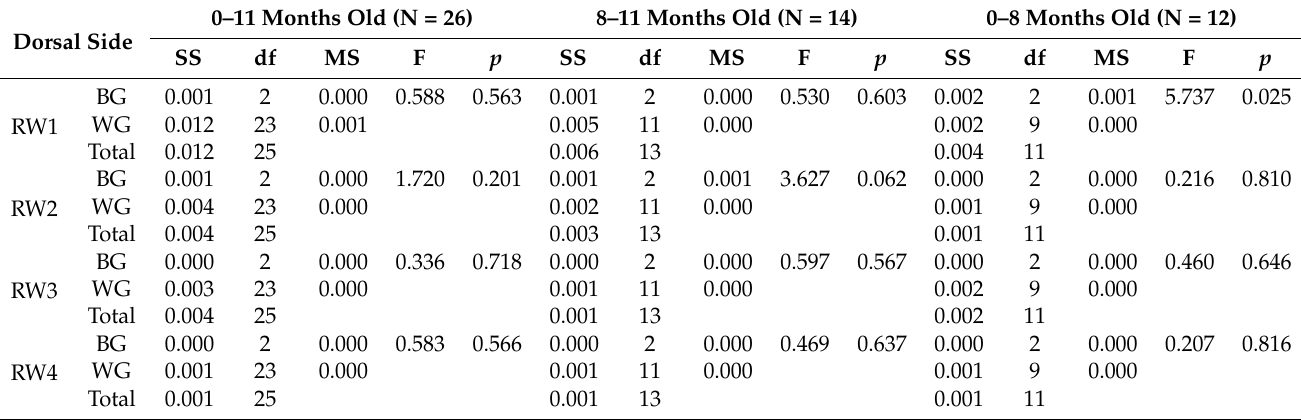
Table 1. ANOVA One-way results from dorsal side data.